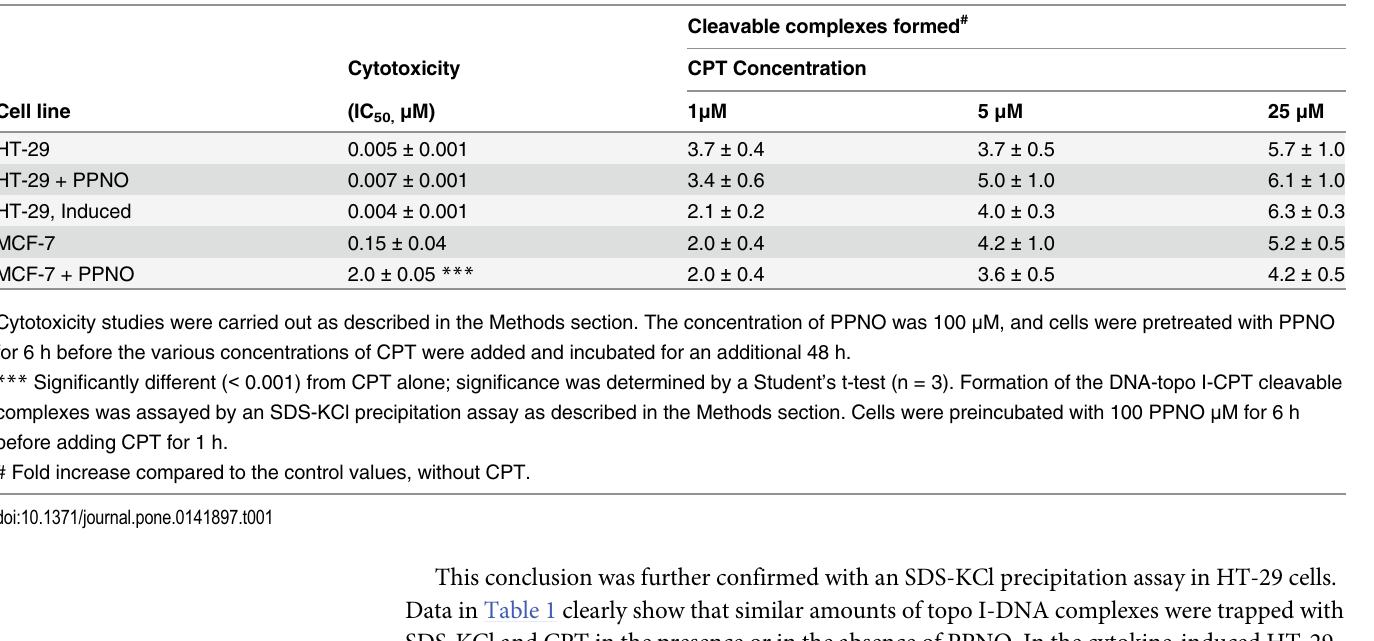
Table 1. Cytotoxicity (IC 50 , μ M) of CPT and cleavable complex formation in the presence or absence of